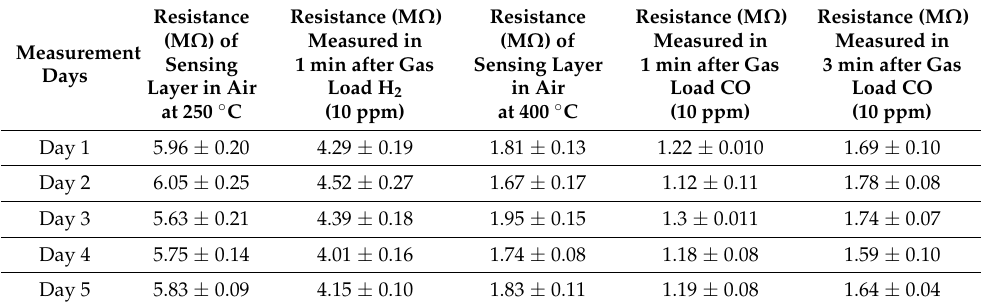
Table 1. Data of the measurements of the sensing layer resistance in air and in loaded gas (H 2 (10 ppm) and CO (10